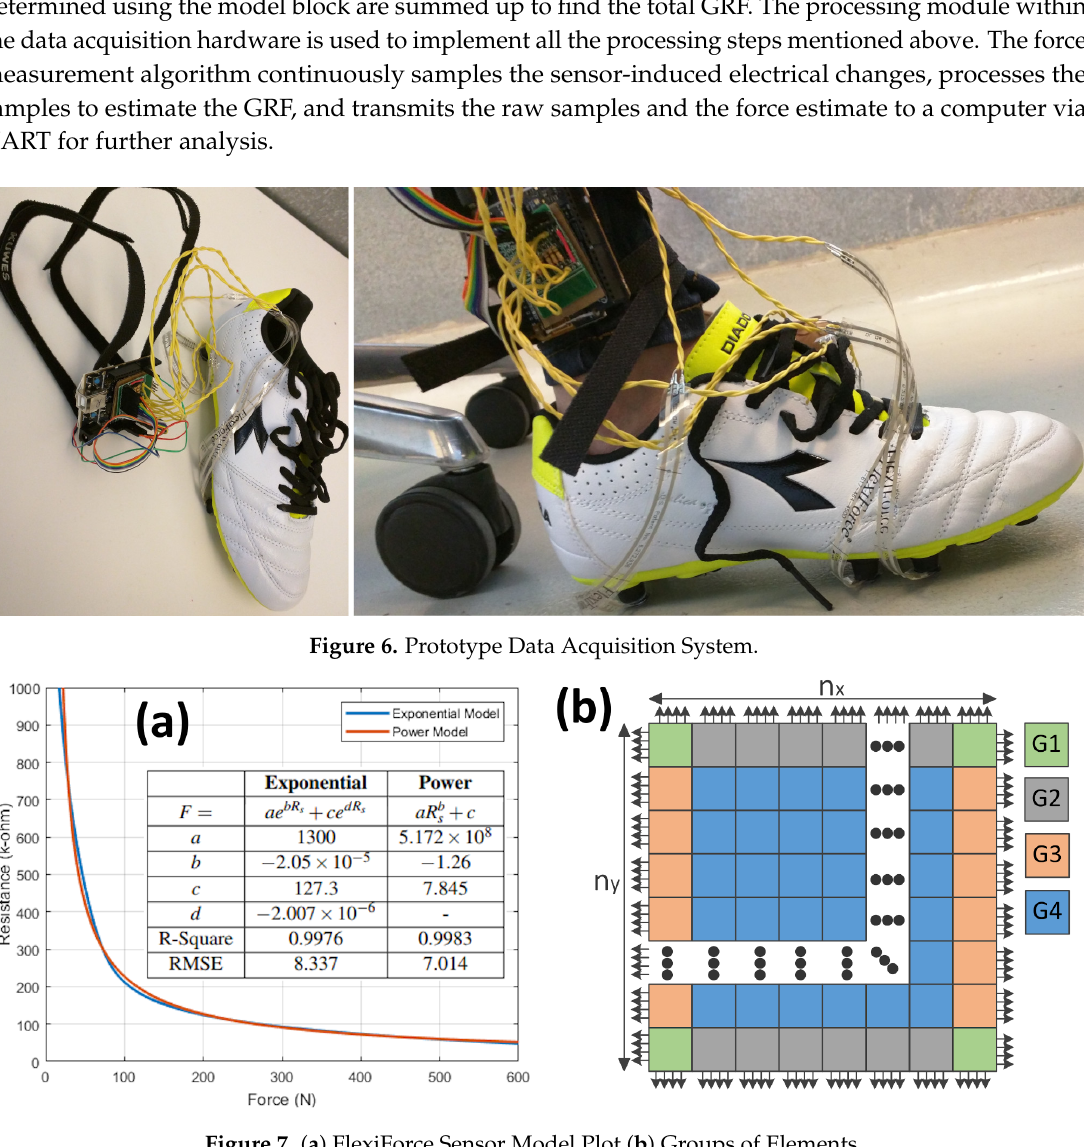
Figure 7. ( a ) FlexiForce Sensor Model Plot ( b ) Groups of